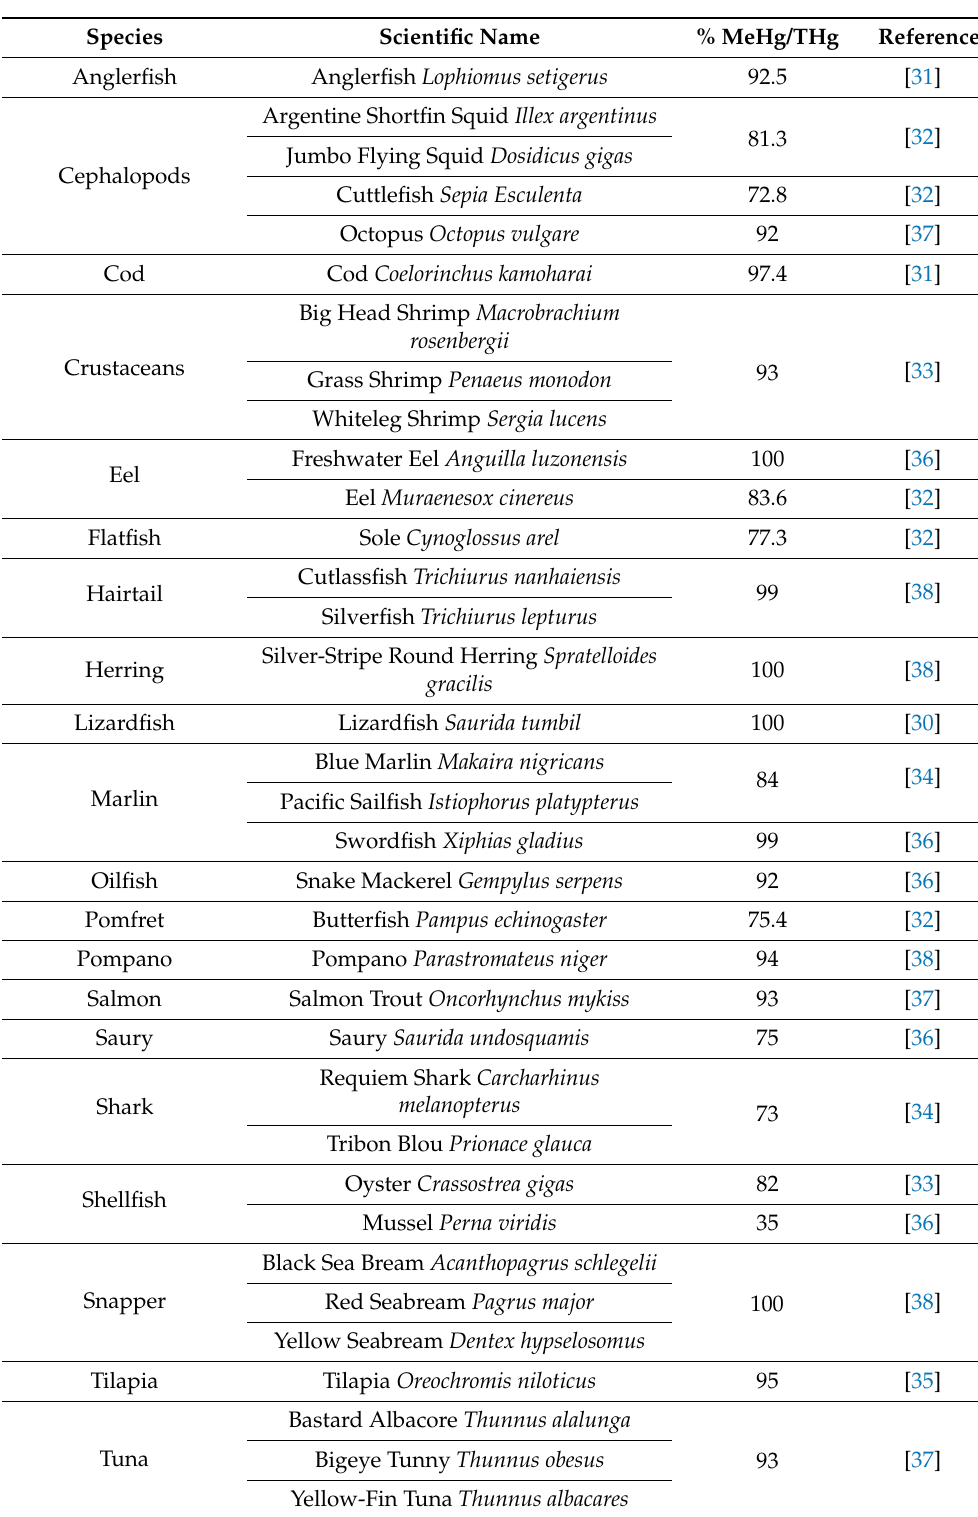
Table 3. Percentages of methylmercury to total mercury (% MeHg/THg) in different seafood species adopted from a previous